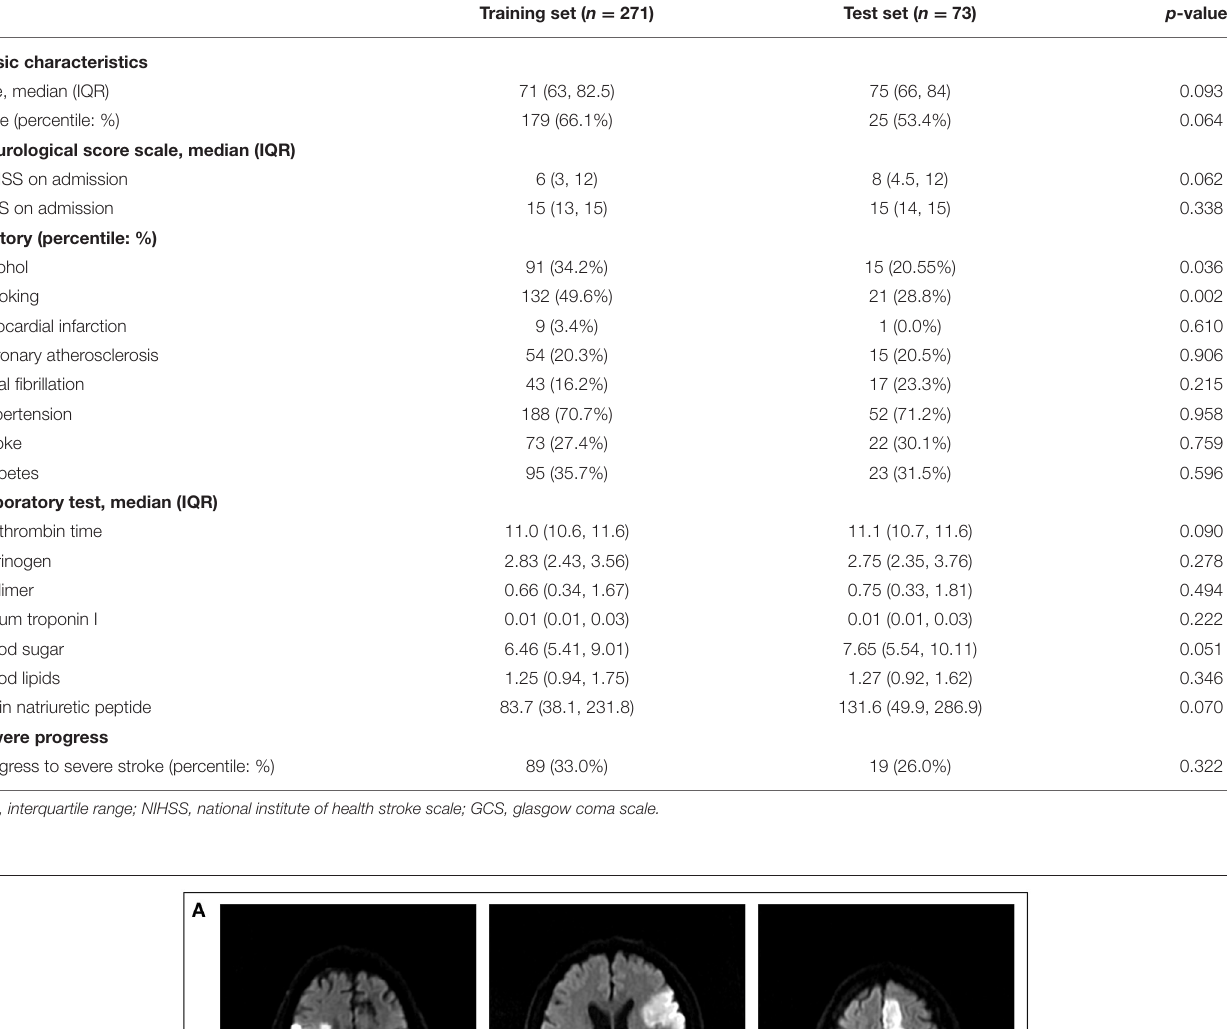
Frontiers in Neurology |